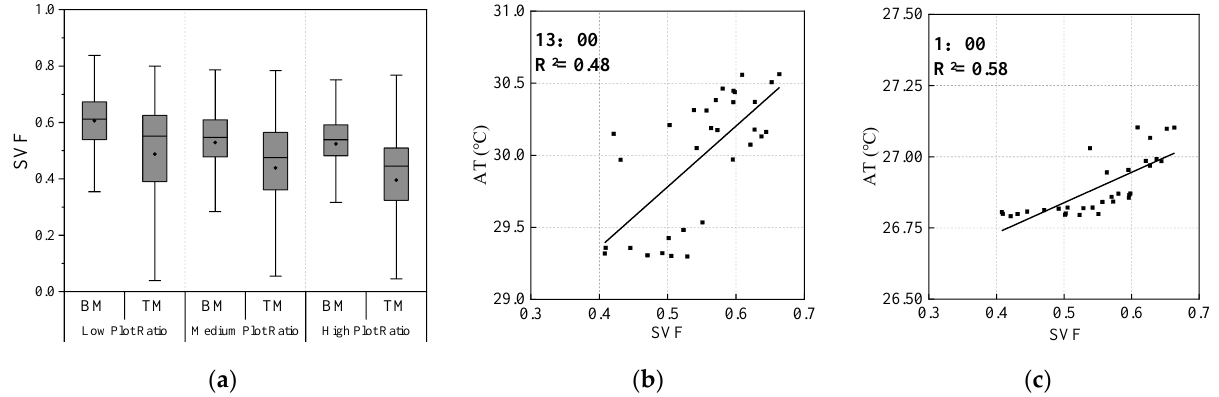
Figure 5. ( a ) SVF of BM and TM in all three types of districts; ( b ) the correlation of SVF and AT in the districts at 13:00; and ( c ) the correlation of SVF and AT in the districts at 1:00.